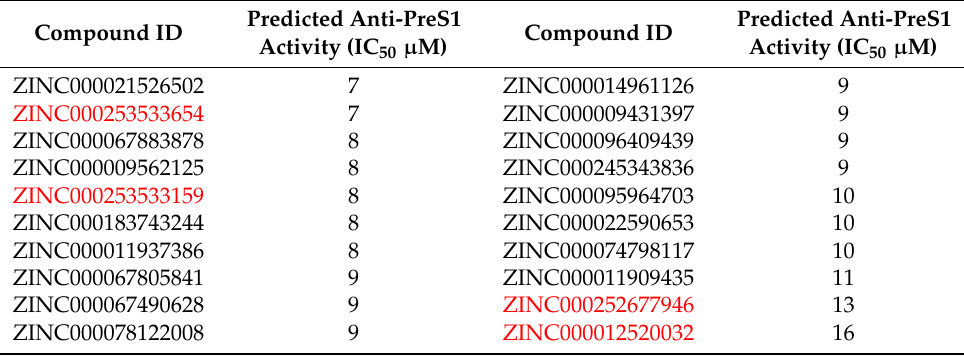
Figure 4. Anti-preS1 activity pharmacophore model for virtual pre-screen of the ZINC 15 library. The model consists of three hydrophobic spheres (shown with green center) and one H-bond acceptor sphere (shown with red center). Excluding volumes are illustrated as blue bubbles. Binding affinities and structures of ligands from Tables 1 and 4 served as data input. Excluded volume sphere radii are 1 Å. Table 5. Top 20 commercially available hits from VS of the ZINC 15 compound library [20] (total amount of compounds: 10,844,830; downloaded on 15 May 2020; reactivity: standard; purchasability: in-stock; pH: ref mid (7.4); charge: − 2, − 1, 0, +1, +2; subset: drug-like). All downloaded data were processed as described in the Material and Methods section. Compounds showing anti-HDV activity are highlighted in